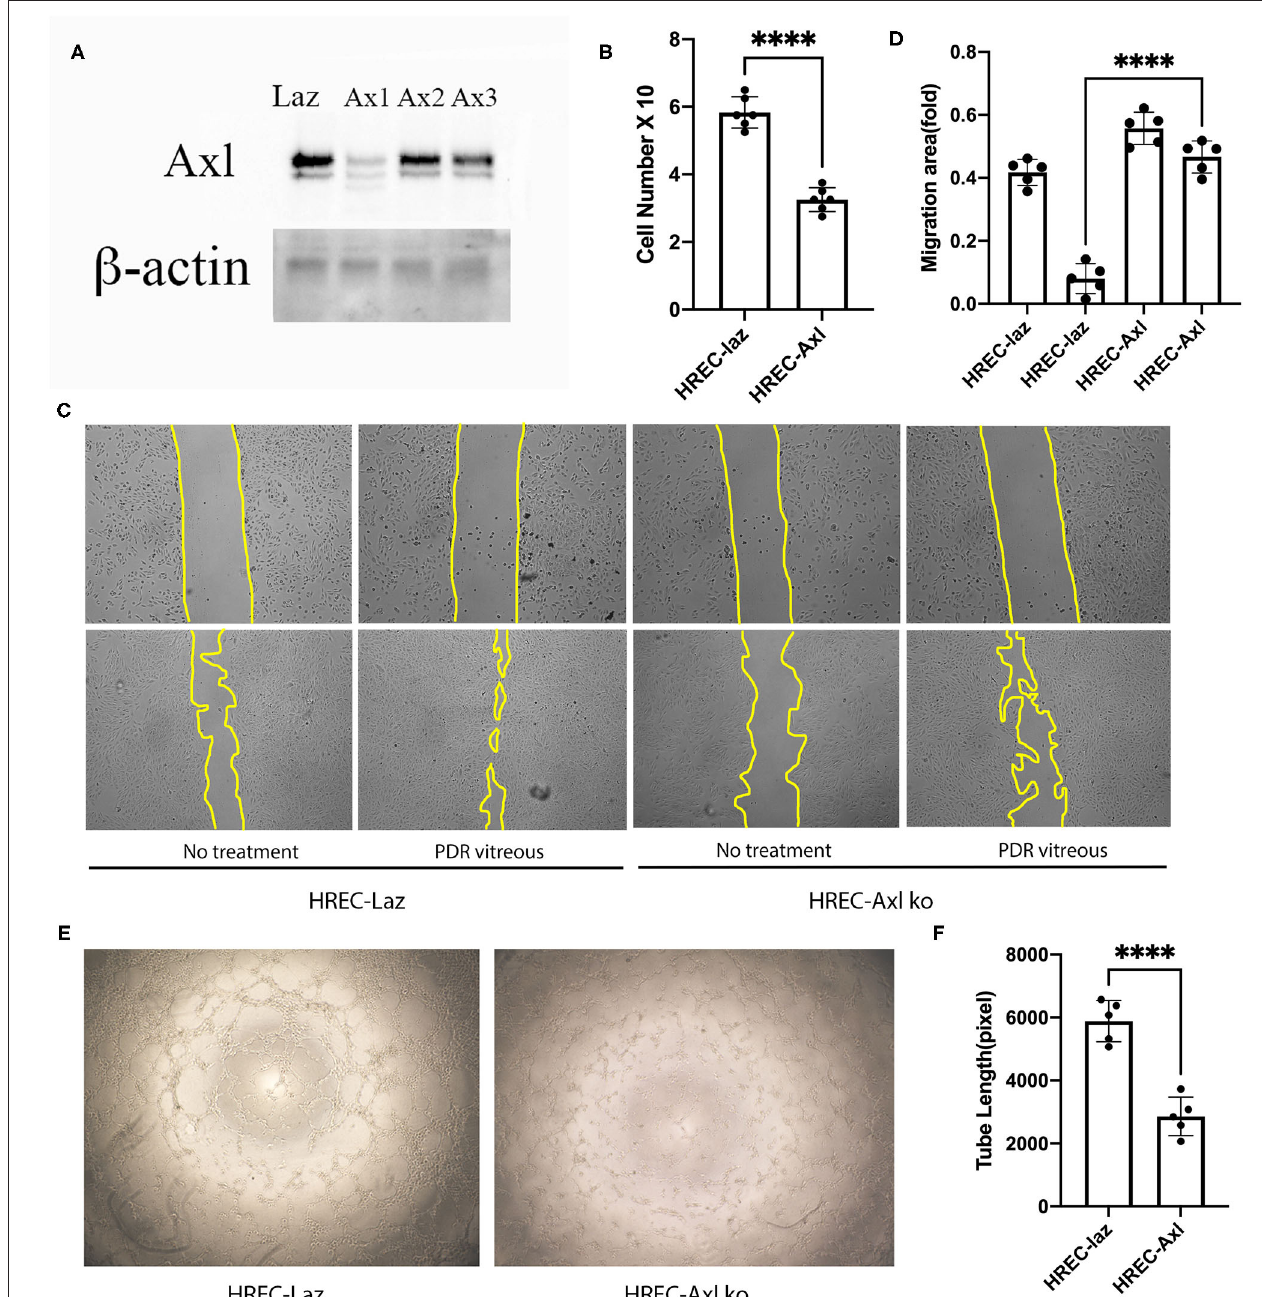
FIGURE 3 | Suppression of Axl suppressed PDR vitreous-induced proliferation, migration, and tube formation. (A) Western blot analysis of lysates from HRECs expressing CRISPR/Cas9 targeting lacZ or Axl using indicated antibodies. This is representative of three independent experiments. (B) Proliferation of HRECs expressing CRISPR/Cas9 targeting lacZ or Axl was induced by PDR vitreous and cell number was counted in a hemocytometer under a light microscope. (C,D) Migration of HRECs expressing CRISPR/Cas9 targeting lacZ or Axl was induced by PDR vitreous in a wound assay. (D) Representative photos of the wound areas, scale bar: 400 µ m; bar graphs of wound areas in five representative photos from three independent experiments. (E,F) A matrigel assay was used to evaluate tube formation of HRECs expressing CRISPR/Cas9 targeting lacZ or Axl induced by PDR vitreous. (F) Representative photos, scale bar: 1,000 µ m; Bar graphs of tube lengths in five representative photos of three independent experiments. ****means the difference was significant and p < 0.0001. in the wound area using Adobe Photoshop (Adobe Systems, San Jose, California, USA) and analyzed using the ImageJ software